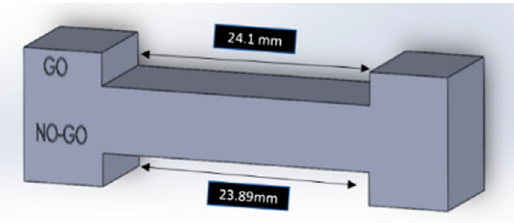
Figure 9. GO ‐ NO calibration gauge designed for the X–Y measurement of coupon. The GO end has an opening of 24.1 mm, and the NO ‐ GO end has a 23.89 mm